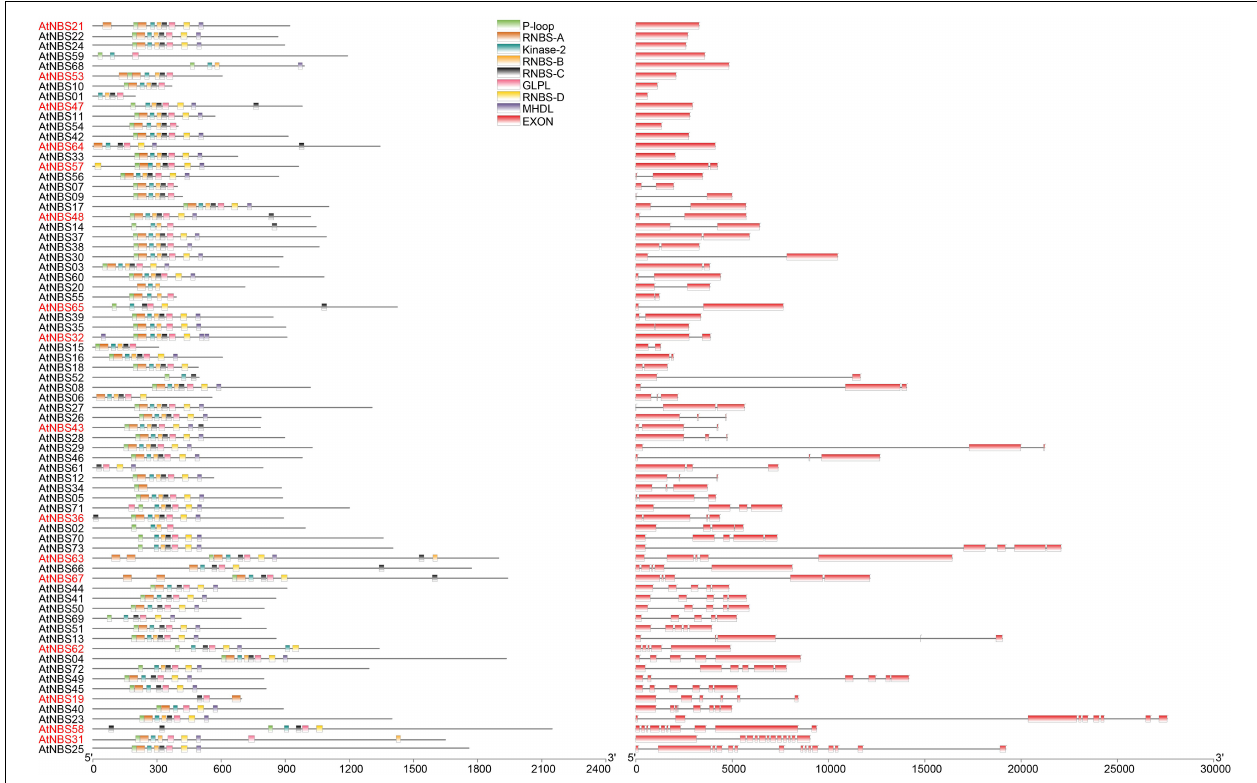
FIGURE 1 | Gene structure and motif analysis of predicted NBS genes. Conserved motif analysis in the NBS domain was performed using the MEME Suite based on protein sequences. In total, eight conserved motifs were identified, and each motif is depicted with boxes of different colors. Their logos are shown in Supplementary Table 2 . A gene name in red font indicates that the gene shows differences in motif order in the NBS domain. The intron/exon organization of NBS genes is represented here, and exon numbers increase gradually from the top to bottom; red boxes depicting exons are separated by introns with thin lines.